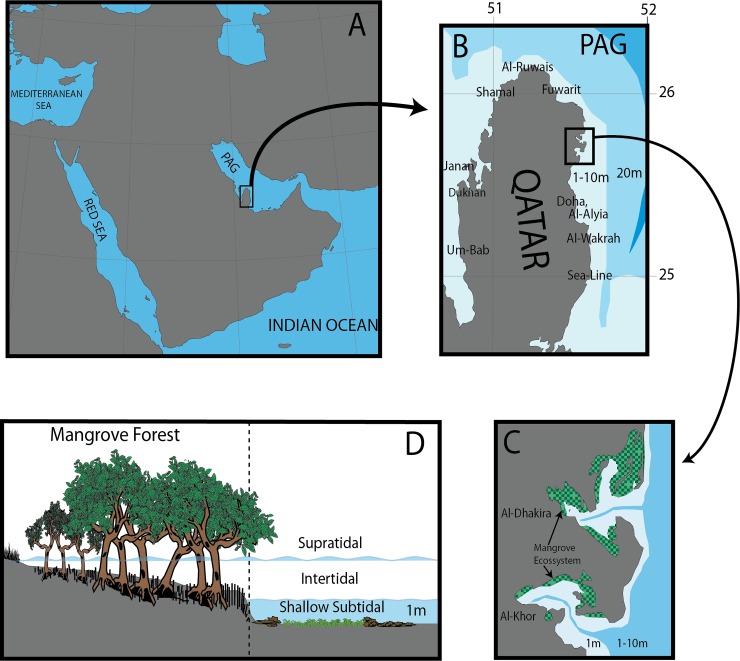
Collection localities in Qatar: (A) the location of Qatar within the
Persian-Arabian Gulf (PAG); (B) the location of the studied mangrove
settings and the other locations around Qatar that was searched for
sponge species; (C) the studied mangrove settings in Al-Khor and
Al-Dhakira highlighting the large area with shallow depth around the
mangrove; (D) schematic profile of the mangrove ecosystem in the coastal
intertidal zone with the forest area and the shallow subtidal zone with
patches of seagrass and oyster-beds (rocks).